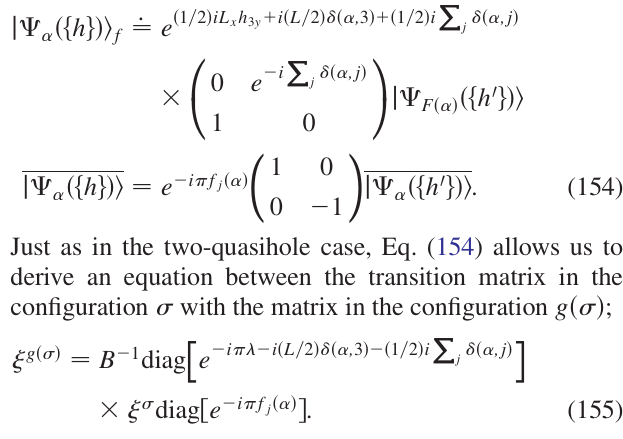
Table V. We recast Eq. (153) in the two-component basis: